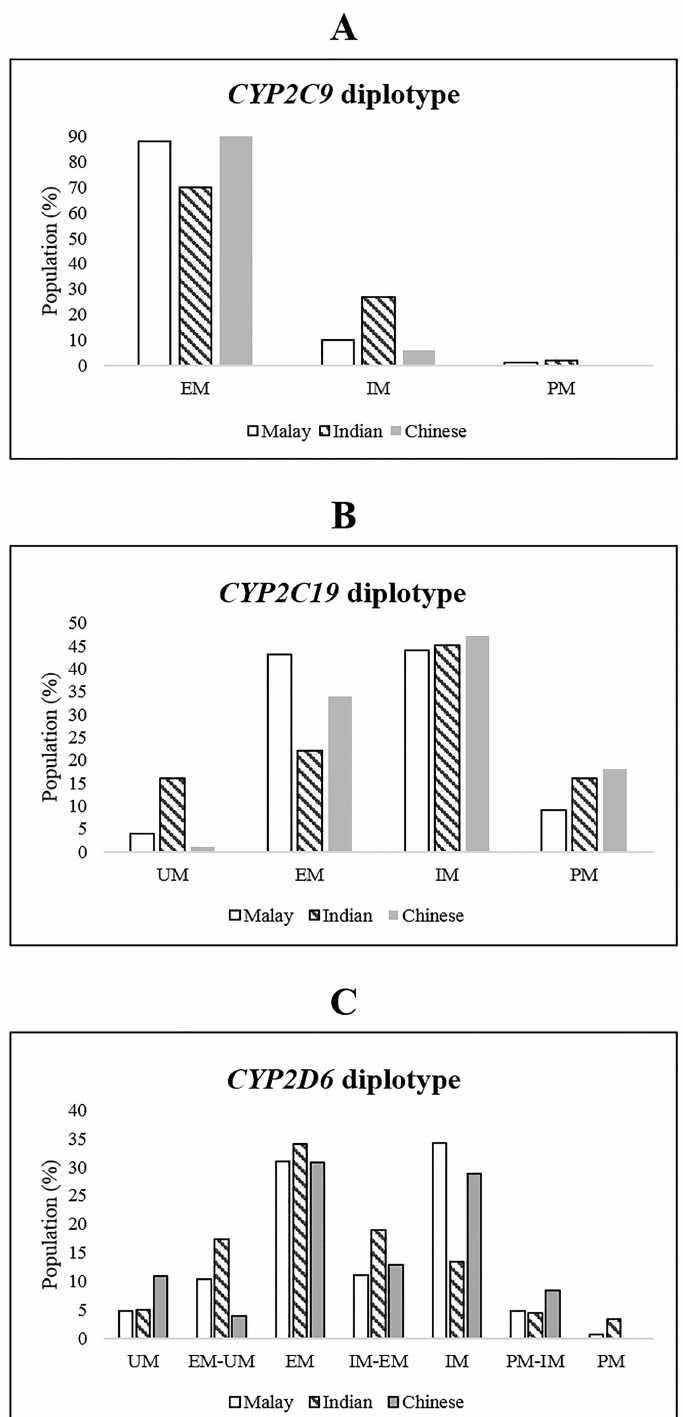
Fig 1. Frequency of metabolizer groups in 3 major ethnic groups of Singapore population. (A) CYP2C9 (B) CYP2C19and (C)